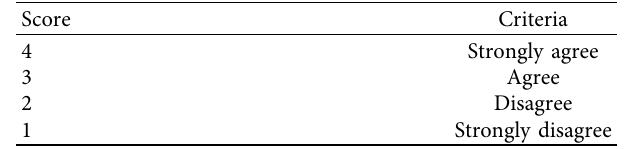
Table 1: Student response criteria.